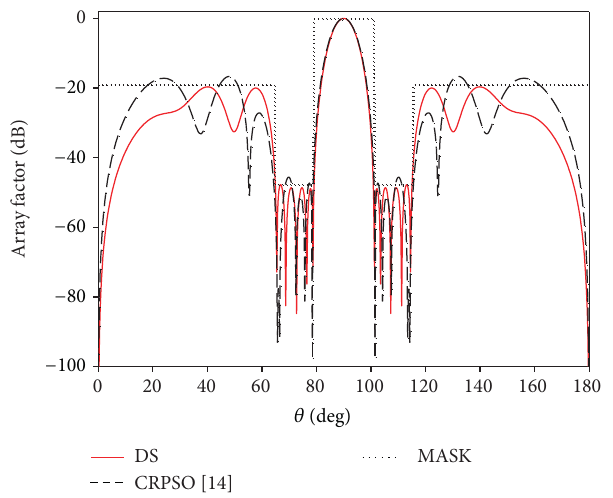
Figure 3: The radiation patterns with wide nulls at [66 ∘ , 78 ∘ ] and [101 ∘ , 113 ∘ ] obtained by DS and CRPSO [14] for the third example (20 elements).